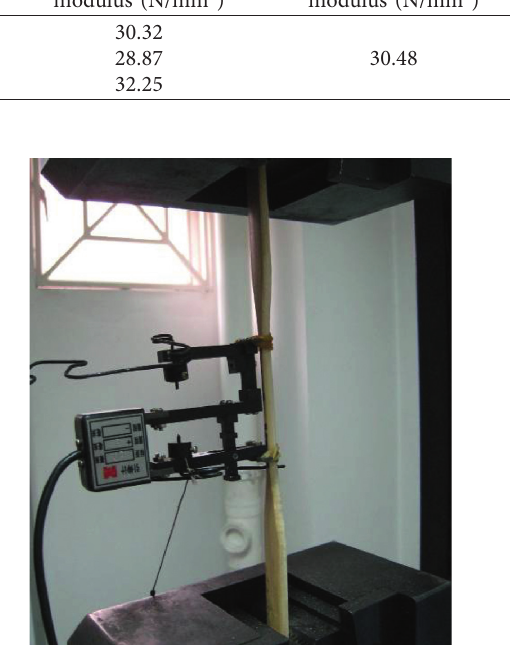
Figure 7: Tensile strength